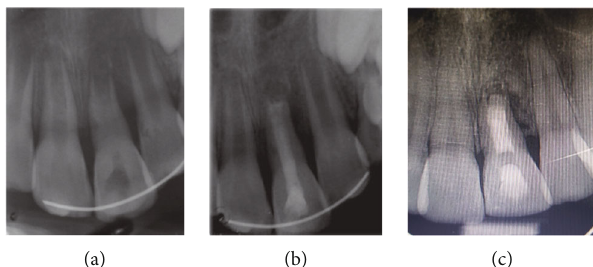
Figure 3: (a) Periapical radiograph showing the initiation of external root resorption on the left central maxillary incisor after 6 weeks. (b) Placement of an MTA plug and root canal obturation with gutta-percha after the resorption process ceased 9 months later. (c) The same tooth at 10-year follow-up.